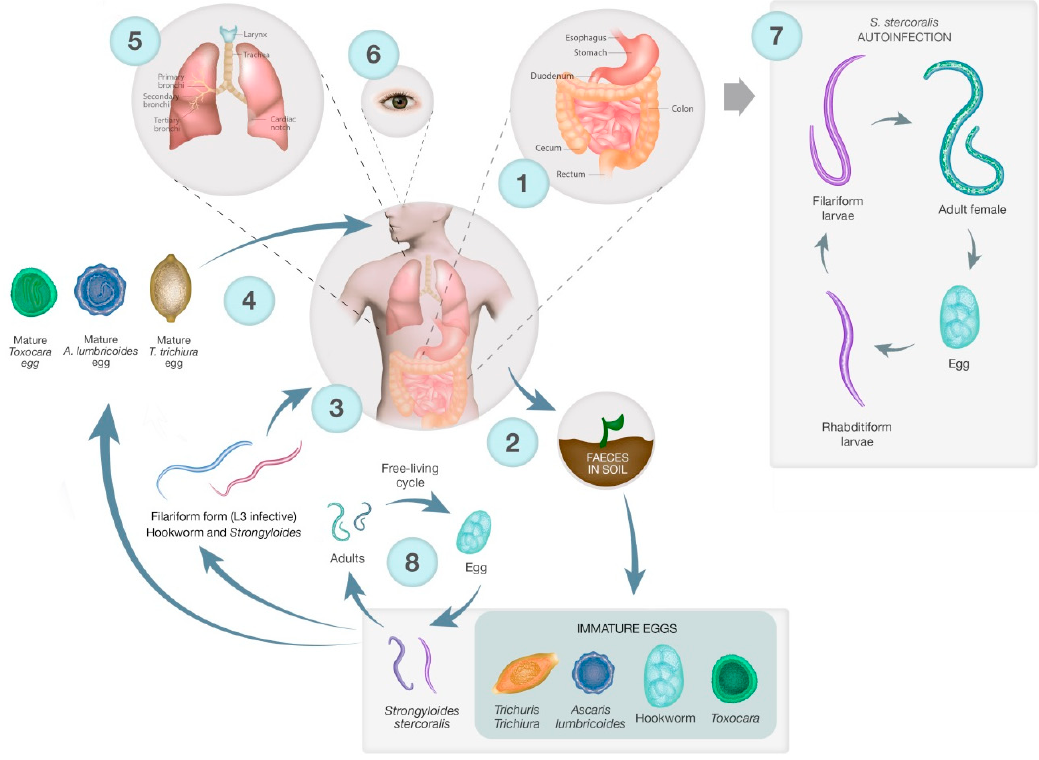
Figure 1. Lifecycles of soil-transmitted helminths (STH), S. sterocoralis, and Toxocara. 1. Adult worms reside in the gastrointestinal tract (GIT). Hookworm, A. lumbricoides, and S. stercoralis adults reside in the small intestine while T. trichiura adults reside in the cecum and ascending colon. Female worms produce eggs which are passed in the stool of an infected person. 2. T. trichiura, Toxocara , and A. lumbricoides eggs mature in soil but do not hatch. Hookworm eggs hatch in soil and mature into L3 hookworm larvae. S. stercoralis eggs hatch into rhabditiform larvae in the gut, which are then excreted via the faeces. Rhabditiform larvae then mature into infective filariform larvae or free-living adults. 3. Infectious L3 filariform larvae of hookworm and S. stercoralis penetrate the skin directly, enter the circulation and migrate to the GIT after passing into the lumen of the lungs. 4. Mature eggs of Toxocara, A. lumbricoides, and T. trichiura are swallowed by the host. The eggs hatch, releasing larvae in the GIT. T. trichiura larvae hatch in the small intestine and mature into adults in the colon while Toxocara and A. lumbricoides larvae penetrate the gut. Toxocara larvae are carried by the circulation to a variety of tissue types while A. lumbricoides larvae are carried to the lungs. 5. Hookworm and A. lumbricoides larvae penetrate the alveolar walls and ascend the bronchial tree to the throat and are swallowed. Once they reach the small intestine the larvae mature into adults. S. stercoralis can also follow bronchial migration, or they can penetrate straight to the GIT. 6. Toxocara larvae can be carried to any tissue type. As humans are dead-end hosts the larvae do not undergo further development once they reach these sites, they can cause local reactions, known as the disease toxocariasis. Ocular toxocariasis, where the larvae penetrate the eye, can result in blindness. 7. S. stercoralis can also undergo autoinfection, where the rhabditiform larvae become infective filarial form larvae in the small intestine and penetrate the gut or perianal region. The filariform larvae can then disseminate to throughout the body. 8. Strongyloides rhabditiform larvae develop into free-living adults that produce eggs from which rhabditidorm larvae hatch. Rhabditiform larvae then develop into infectious filariform larvae and penetrate a human host. The free-living cycle exists for one generation cycle only.